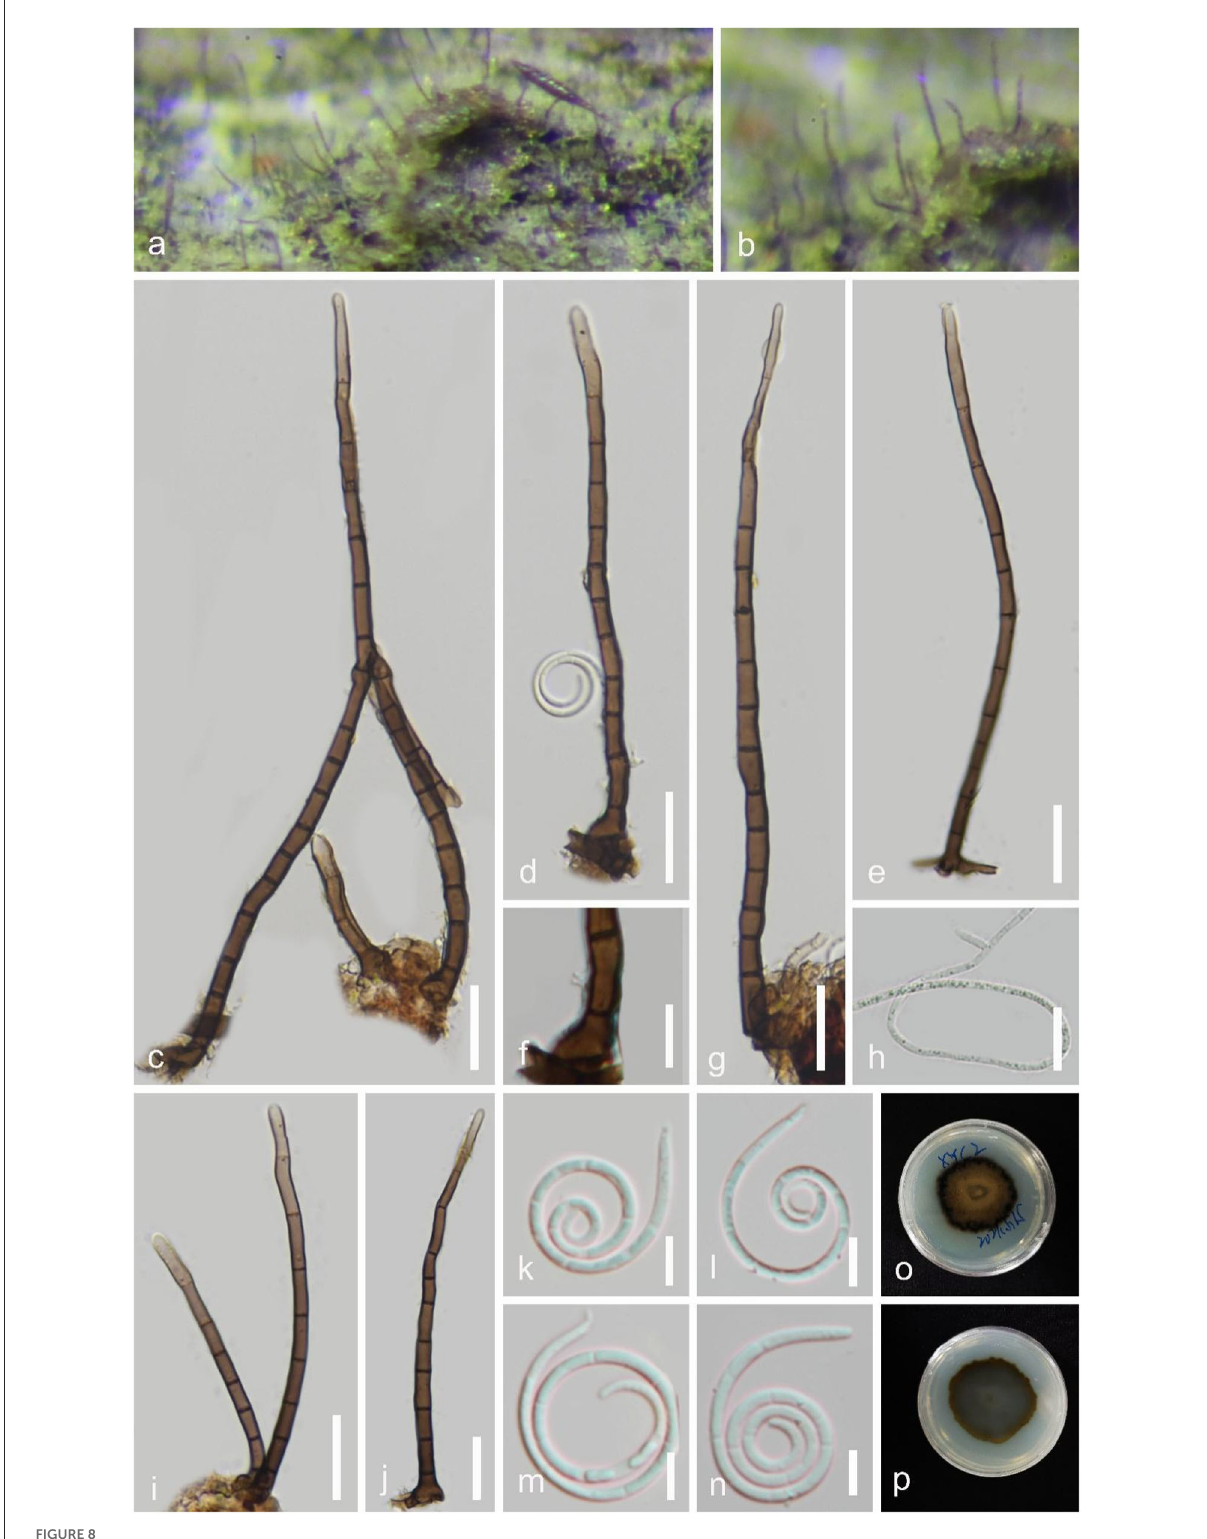
FIGURE8 Helicosporium viridisporum (GZAAS 22-2008, holotype). (a,b) Colony on decaying wood. (c–e,g,i,j) Conidiophores and conidia. (f) Conidiogenous cells. (h) Germinating conidium. (k–n) Conidia. (o,p) Colonies on PDA observed from above and below. Scale bars: (c–f,i,j) = 20 µ m, (g,h) = 10 µ m, (k–n) = 5 µ